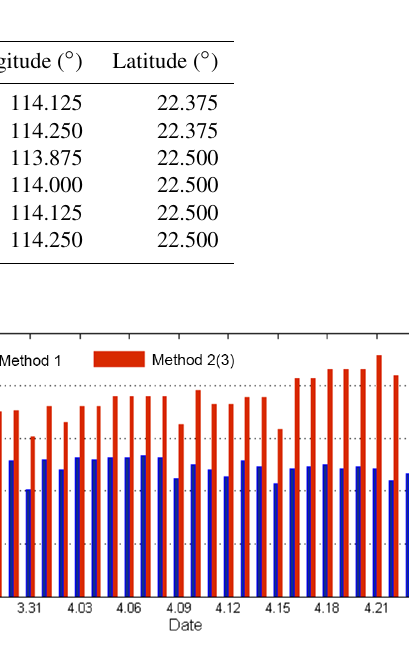
Figure 3. The number of signals used for different methods in the experiment.